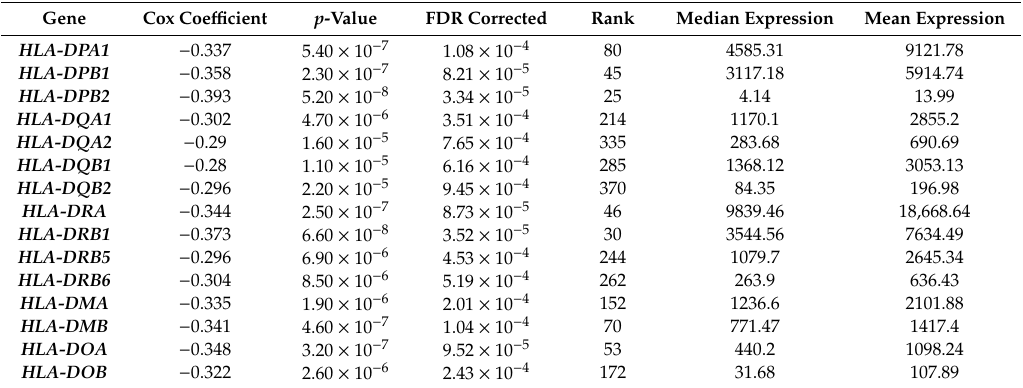
Table 2. Association of 15 HLA class II gene expressions in cutaneous melanoma with survival generated from Cox regression analysis via OncoLnc tool.